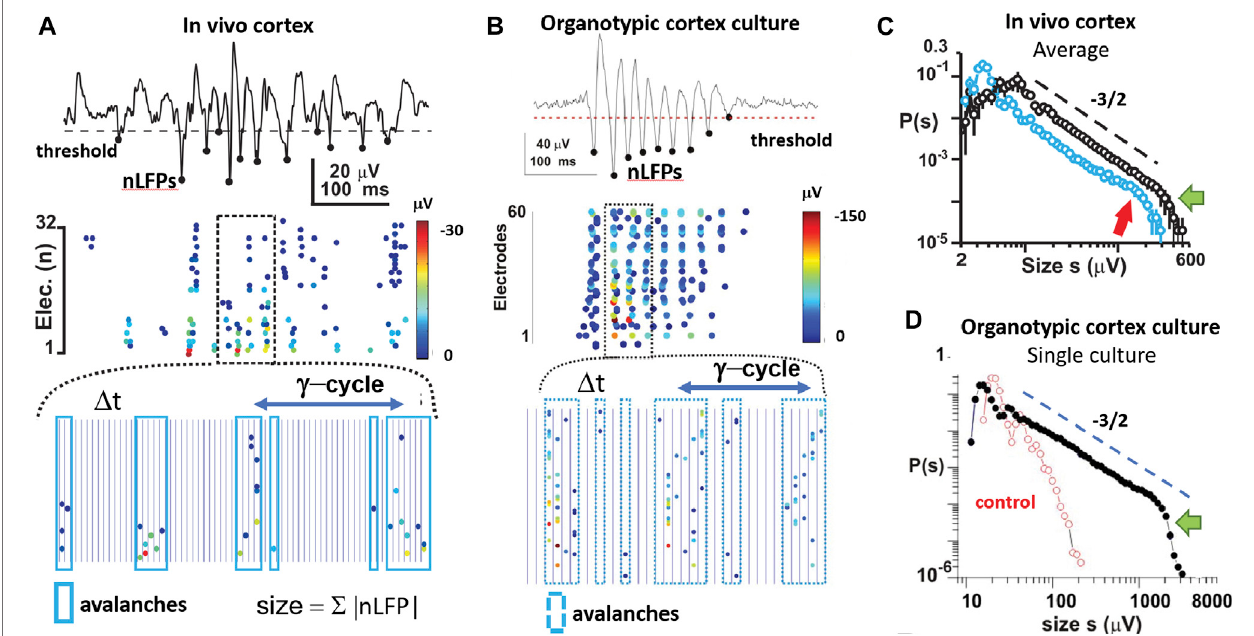
FIGURE 4 | The third dynamical motif of self-organization: neuronal avalanches embedded in nested oscillations. (A) Nested θ / γ -oscillations in the super fi cial layer ofa2-week-oldrat invivo organizeasneuronalavalanchesthatpredominantlyemergeatoscillationcycles. Top :singlecorticalelectrodewithcontinuousLFPfromwhich negative peak de fl ections (nLFP; fi lled circles ) are identi fi ed after threshold crossing. Middle : corresponding raster of nLFPs on the full 32-MEA exhibiting columnar, variable bouts of synchronization in space and time. nLFP peak amplitudes are color coded. Bottom : expanded view of identi fi ed avalanches ( blue rectangles ) during each γ -oscillation period plottedin discrete time steps ofduration Δ t( verticallines ).Sizeofanavalancheisde fi ned asthesum ofabsolute nLFPamplitudes within each avalanche. (B) As in A but for a transient γ -oscillation in an organotypic culture. (C) At the end of the second week postnatal ( black ), avalanches distribute in size from 10 to 300 μ V followed by a cutoff ( green arrow ; n (cid:2) 7 animals). Broken line : slope of − 3/2 as guide to the eye. Size distribution is slightly bimodal ( red arrow ) at the beginning of the second week postnatal ( blue ; n (cid:2) 5 animals). (D) Power law in avalanche size distribution for a single culture and exponential size distribution obtained from time-shuf fl ed controls in which spatial and temporal correlations among nLFPs are destroyed (reprinted with permission from [52]; Copyright 2008 National Academy of Sciences).